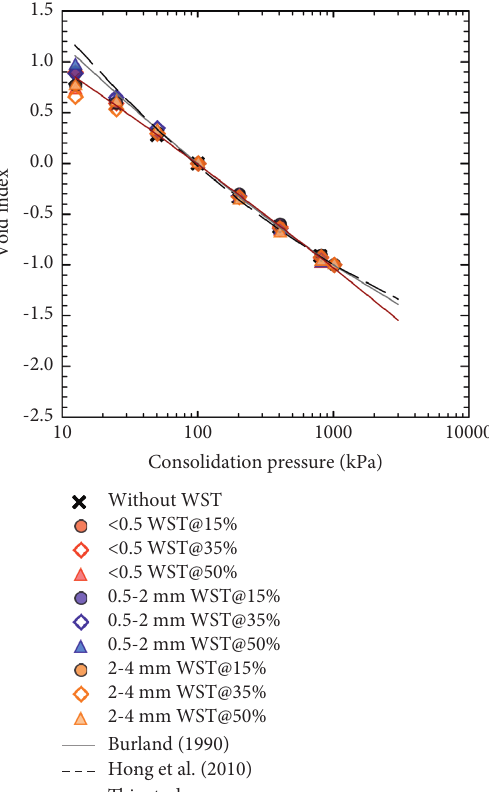
Figure 6: Comparison of normalized compression curves with ICL and